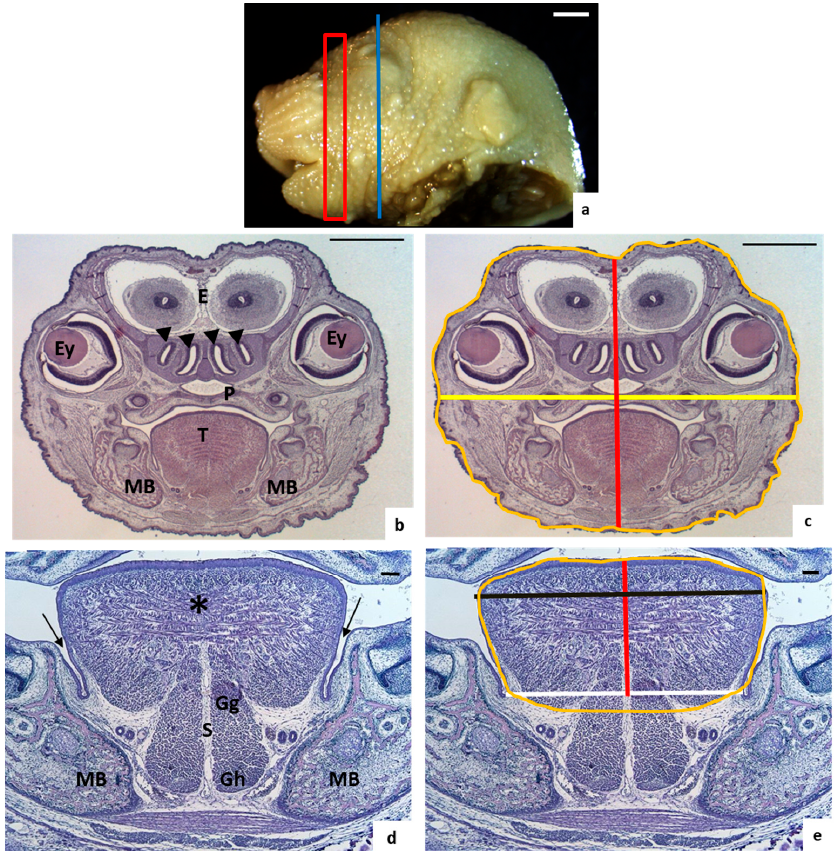
Figure 1. Tongue and head measurements. ( a ) Lateral view of the control fetus head. The red square marks the bloc of sections selected for tongue measurements. The blue line crossing the eye indicates the chosen region for head measurements. Scale bar: 1 mm; ( b ) Coronal section of a control head showing the references for head measurements: the nasal conchae (arrowheads) and the eyes (E: encephalon; Ey: eye; MB: mandibular bone; P: palate; T: tongue). Scale bar: 0.5 mm; ( c ) Description of head measures: yellow line for head width, red line for head height and orange line for head area; ( d ) Control section showing the tongue body with intrinsic muscles (asterisk), lingual septum (S), the lingual-mandibular sulcus (black arrows), mandibular bone (MB) and genioglossus (Gg) and geniohyoid (Gh) muscles. Scale bar: 100 μ m; ( e ) Description of tongue measurements: black line for width of the widest zone of the tongue, red line for height, white line for width of the base of the tongue, and orange line for area. Scale bar: 100 μ m.